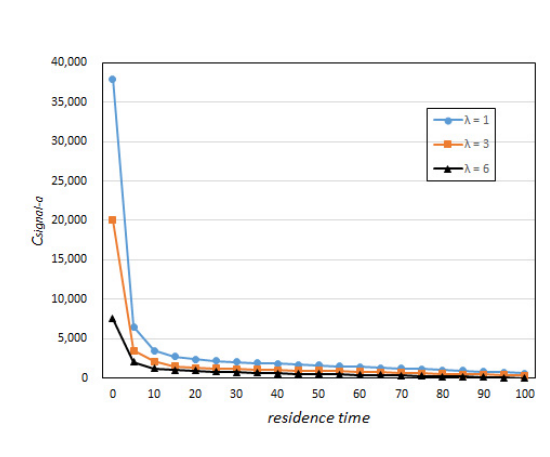
Figure 8. Packet data transmission overhead ( (cid:22) = 0 : 1 ).